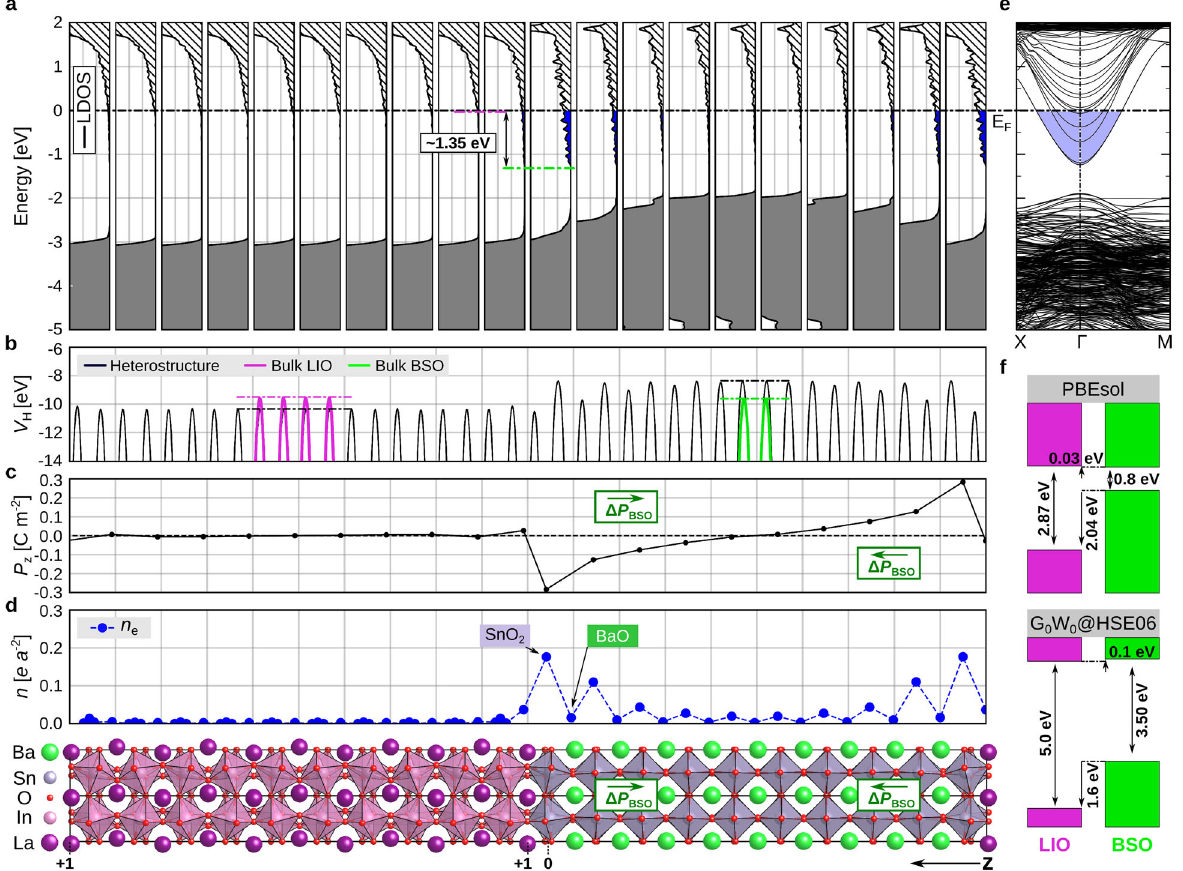
Fig. 2 Non-stoichiometric periodic nn-type heterostructure. The system is formed by LIO 10 /BSO 10 in out-of-plane direction z (bottom), which is shared between panels ( a – d ) as their horizontal axis. The LaInO 3 block is terminated by a (LaO) + 1 plane on both sides. a Local density of states per unit cell (LDOS). The Fermi level is set to zero, and the electron population of the (original) conduction bands is shown as shaded blue area (also in panel ( e )). The dashed green and pink lines indicate the alignment of the conduction-band edges of the two materials at the interface. b In-plane averaged electrostatic potential along the z direction. c Total polarization per unit cell. d Distribution of the electron charge density obtained by integrating over the occupied conduction states indicated by the blue area in panel ( a ). e Electronic band structure along X- Γ -M. f Band alignment as obtained by using the band gaps of the bulk systems (PBEsol, top and G 0 W 0 @HSE06, bottom), considering the energy difference between the potential of the bulk and the periodic heterostructure as shown in panel ( b ). The alignment at the interface obtained by PBEsol can be seen in panel ( a